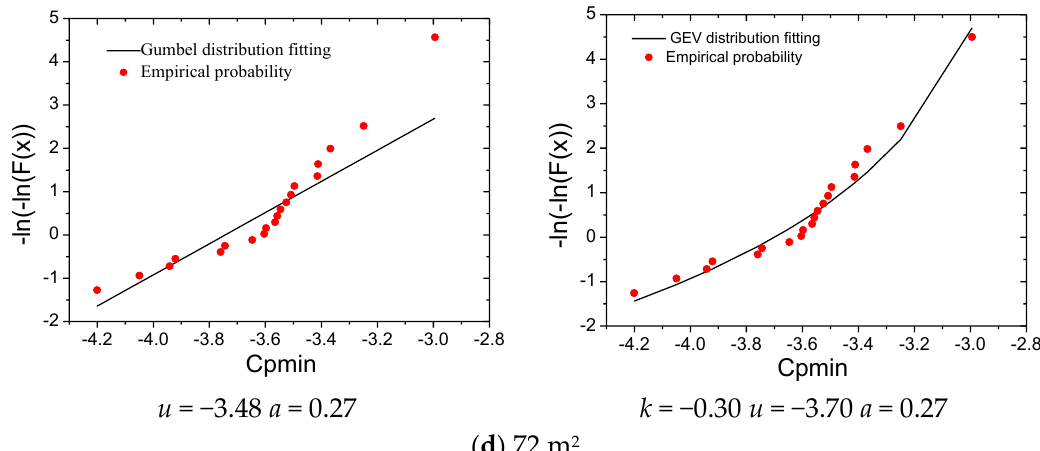
Figure 4. The probability distribution fitting for the area-averaged extreme pressure coefficients for different areas: ( a ) 2 m 2 , ( b ) 10 m 2 , ( c ) 25 m 2 , ( d ) 72 m 2 .